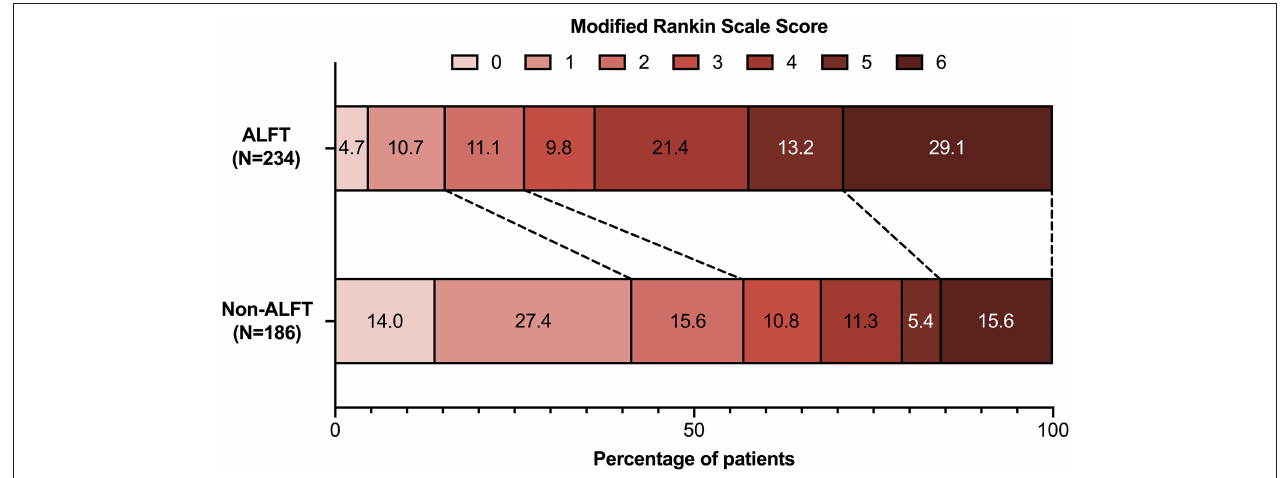
FIGURE 1 | Comparisons of modified Rankin scale scores at 90 days between the ALFT group and the non-ALFT group. ALFT, abnormal liver function test.